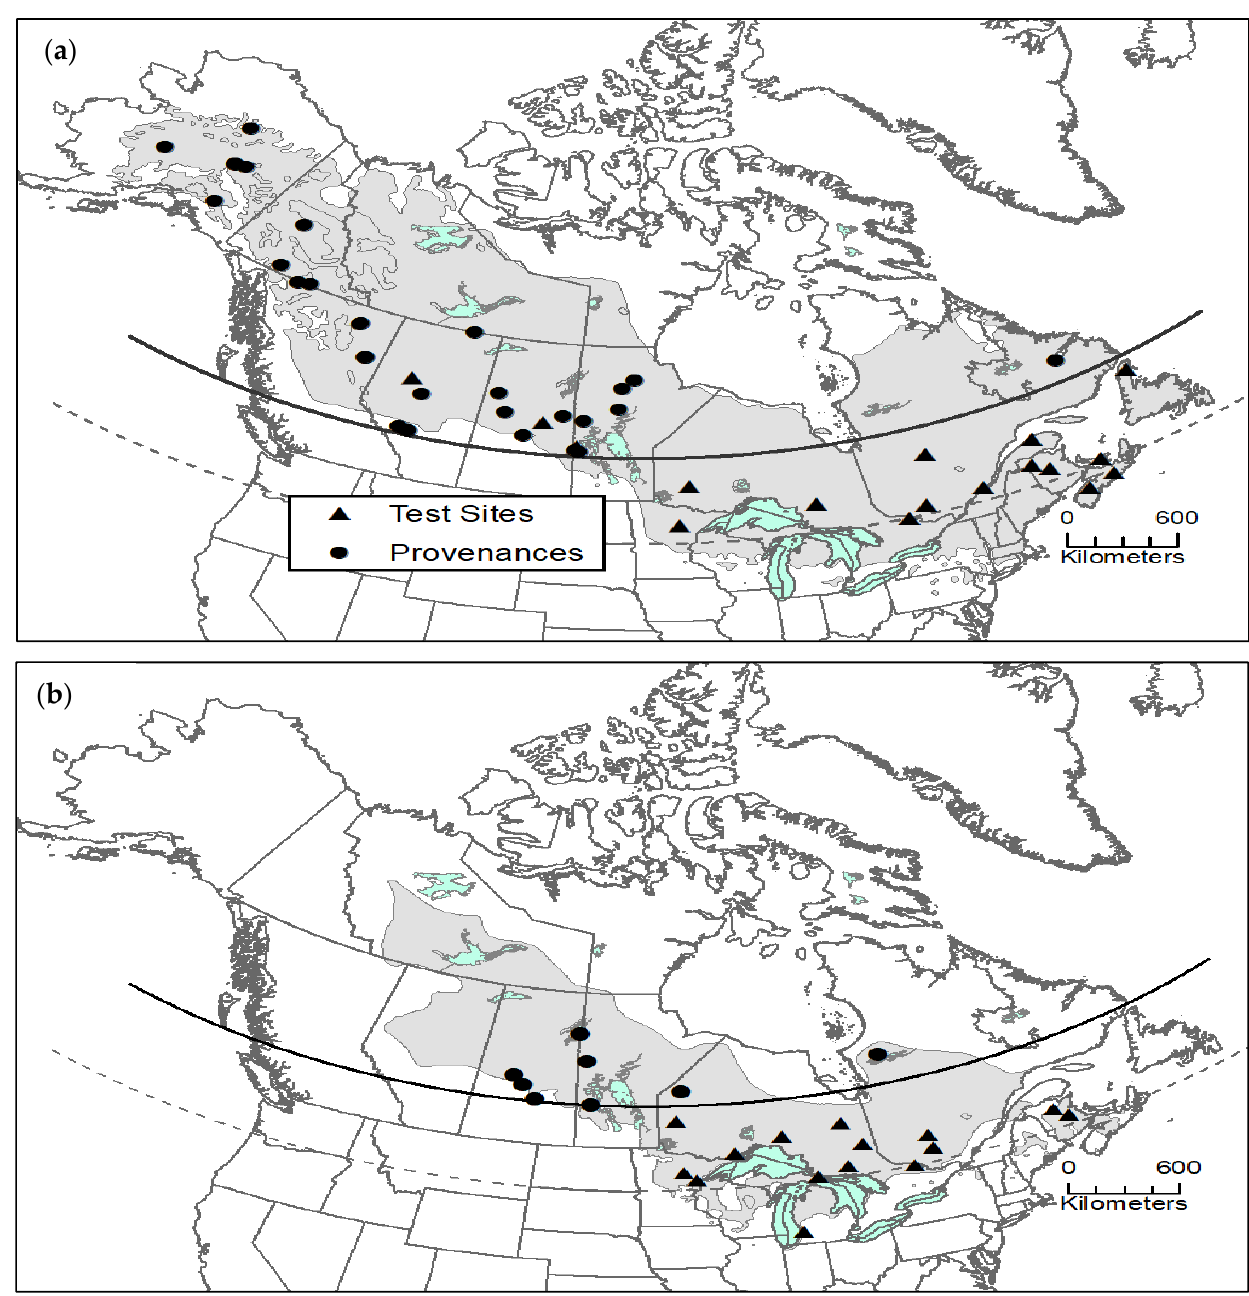
Figure 2. Locations of northern provenances (circles) and the test sites (triangles) where they were planted as part of rangewide provenance studies for ( a ) black spruce and ( b ) jack pine. The solid black line indicates 52° N, the cut-off used in the current study to define northern provenances; the dashed gray line indicates 46° N, the cut-off between central and southern seed sources. Gray shading indicates the geographic range of the species and blue shading delineates large water bodies.